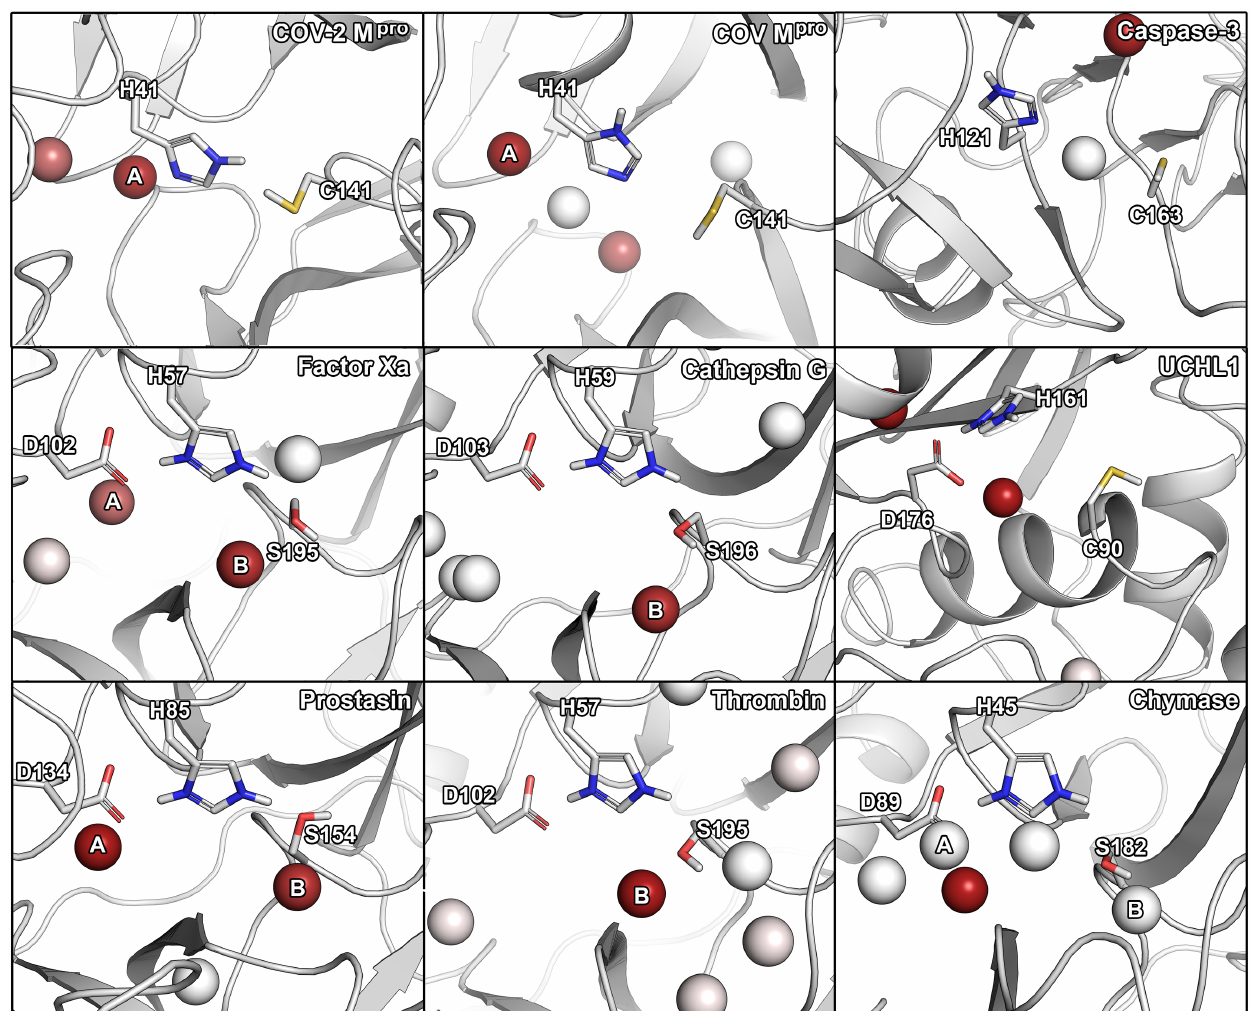
Figure 1. Hydration hot-spots of the selected panel of proteases in relation to the catalytic residues. To allow a direct comparison, the protein structures were aligned according to their catalytic residues. Two most consistently occurring hydration sites are indicated by A and B. The hot-spots are color-coded according to the occupancy of a particular region by identified hydration hot-spots. Hydration hot-spots with highest occupancy are colored in dark red, those with low occupancy in